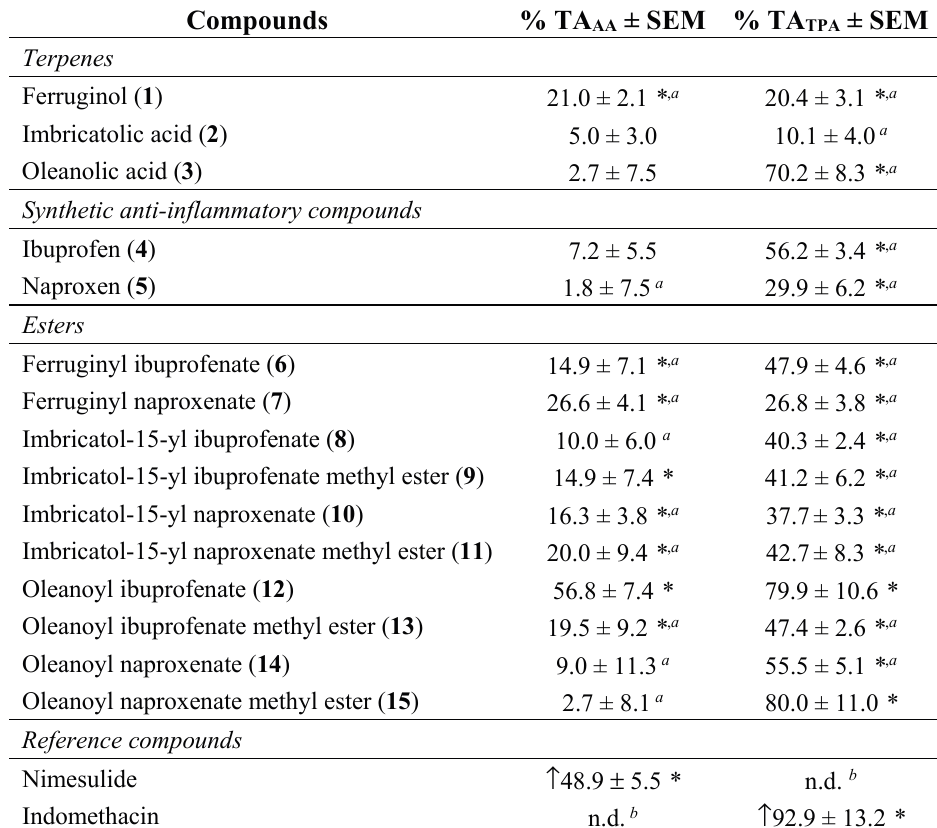
Table 1. Topical anti-inflammatory effect of compounds 1 – 15 in the mice ear edema model induced by arachidonic acid (TA AA ) and 12- O -tetradecanoylphorbol 13-acetate (TA TPA ). Results are expressed as percent reduction of the ear